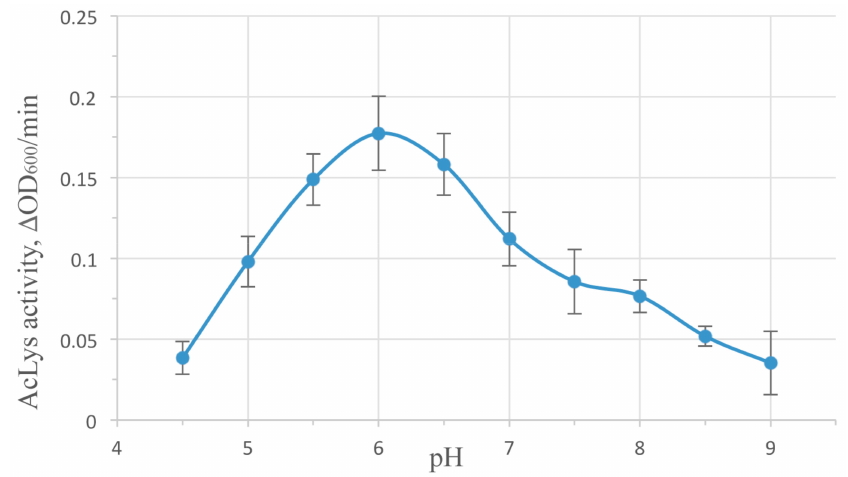
Figure 3. pH influence on AcLys activity. The reactions were run in 10 mM Tris-HCl, 10mM K 2 HPO 4, 10 mM Na acetate adjusted to corresponding pH with NaOH at 25 ◦ C. Enzyme concentration 1 µ g/mL. Substrate— E. coli CR63, preliminary washed with deionized water and frozen at − 70 ◦